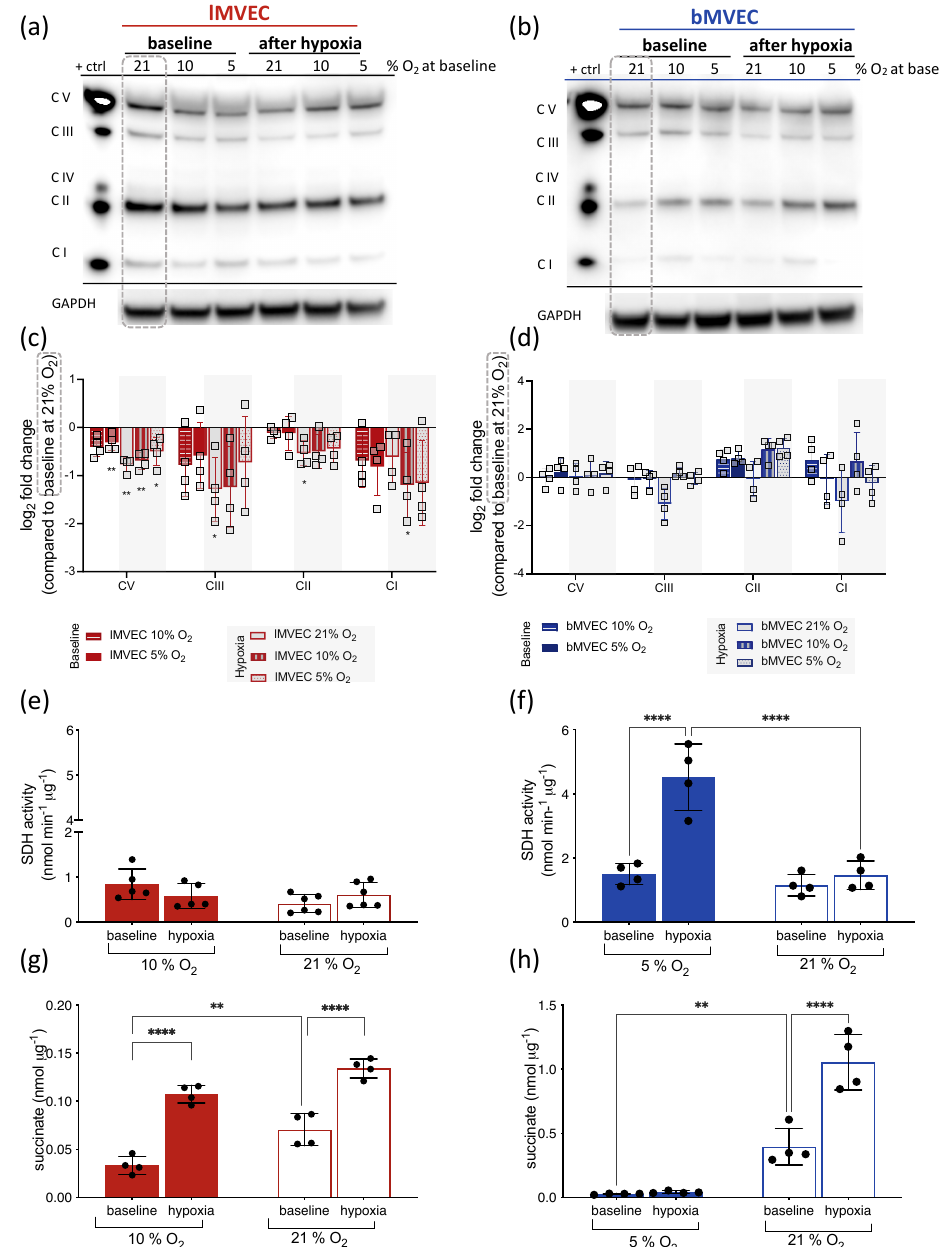
Figure 6. Brain and Lung MVEC have different patterns of mitochondrial ETC components. Whole protein extracts were collected from MVEC from the three baseline (21%, 10% O 2 and 5% O 2 ) and after exposure of each to 1% O 2 for 24 h. The lysates were probed by Western blot using a mitochondrial antibody cocktail. Representative images are shown for lung ( a ) and brain ( b ) MVEC expanded in each O 2 environment; ( c , d ) MVEC mitochondrial protein quantification (lung and brain, respectively) was performed by densitometry, normalised to loading control (GAPDH) and presented as a ratio to the levels of each mitochondrial complex at 21% O 2 (dashed grey box in each blot highlighting lane used as “control”); data are shown as log 2 (fold change) ± SD, statistical significance was assessed by one sample t -test; * p < 0.05, ** p < 0.01, n = 4. Complex I was detected at levels below threshold and thus could not be accurately quantified. SDH activity for l MVEC ( e ) and b MVEC ( f ) and succinate levels ( g , h ) for lung and brain MVEC, respectively) were measured at baseline and after 24 h hypoxia 1% O 2 ), following priming in either physioxia (5% O 2 for brain, 10 % O 2 for lung) or hyperoxia (21% O 2 ). Data are shown as average ± SEM and significance was assessed by 2-way